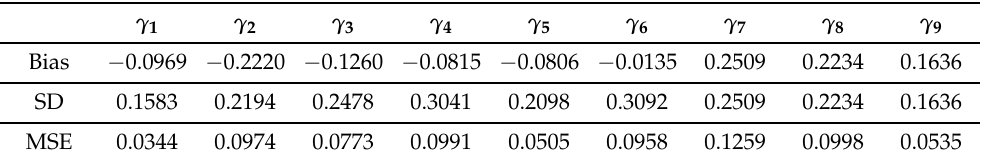
Table 5. Bias, SD and MSE evolutions with respect to the parameter γ variation for PLGSIMF with the identity link function and n = 1000.